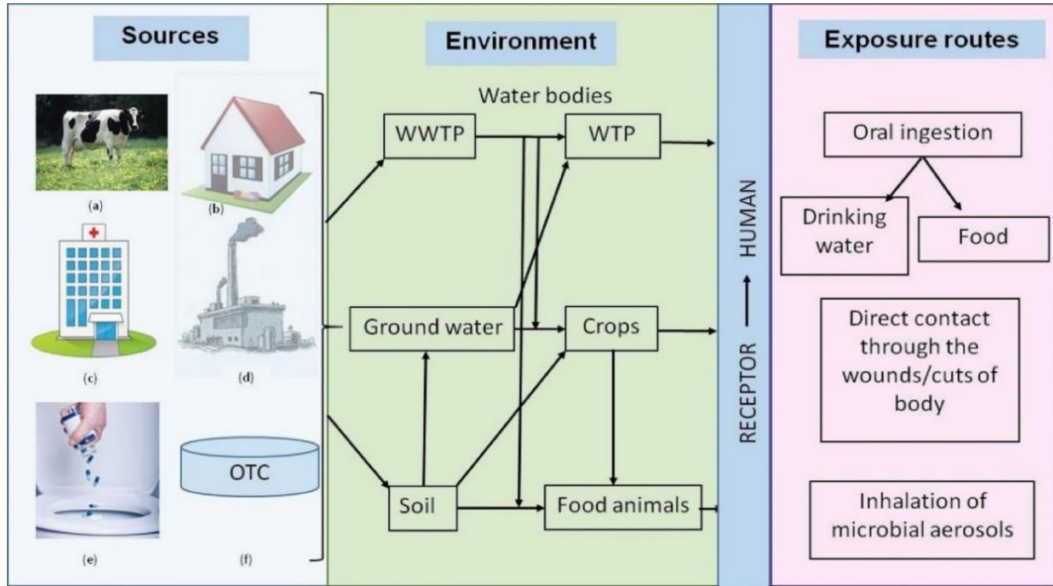
Figure 5. Sources of antibiotic usage, its spread, and transfer of resistance genes to humans. The excessive usage of antibiotics as growth stimulants in livestock and other food animals can contaminate water sources when animal excreta is washed off with water into the environment ( a ). The contamination of sewage treatment plants can be a result of excessive human usage of antibiotics ( b ). Hospitals and pharmaceutical industries contribute significantly to wastewater treatment plants’ pollution by antibiotics when they are illegally let into sewage systems ( c , d ). Improper disposal of antibiotic pills and unprescribed over-the-counter antibiotics can contaminate wastewater treatment plants ( e , f ) [104]. Copyrights